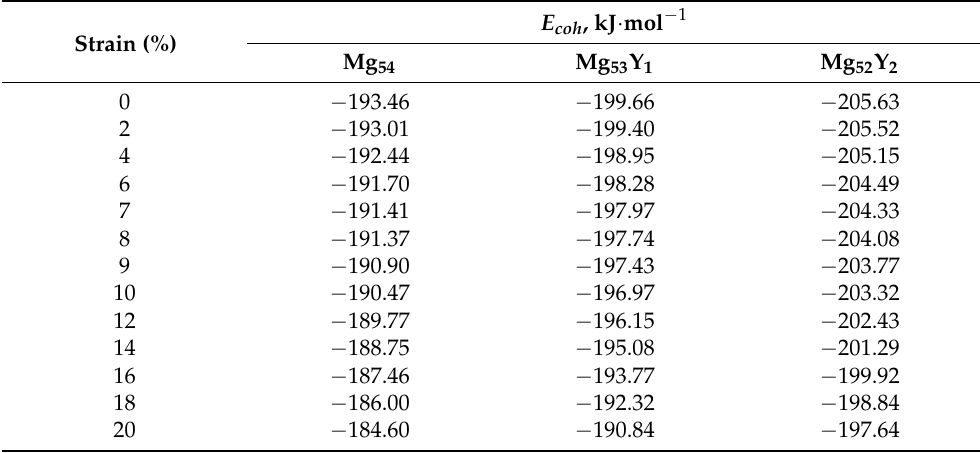
Table 1. The cohesive energy of Mg 54 , Mg 53 Y 1 and Mg 52 Y 2 under different